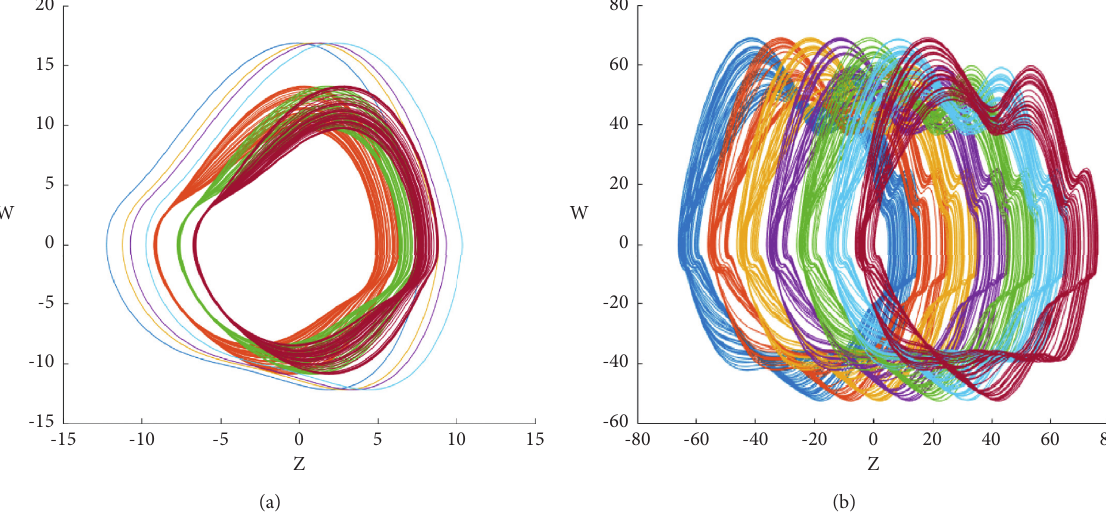
Figure 6: Projection of systems (1) and (2) in the zw plane. Varying the control parameter k , (a) from − 3 to 3 in system (1), shows that this system is not offset boostable. However, in (b), when k changes from − 30 to 30 in system (2), the system shows offset boostable property. In both panels, a � 3 . 5, b � 1, and ( x